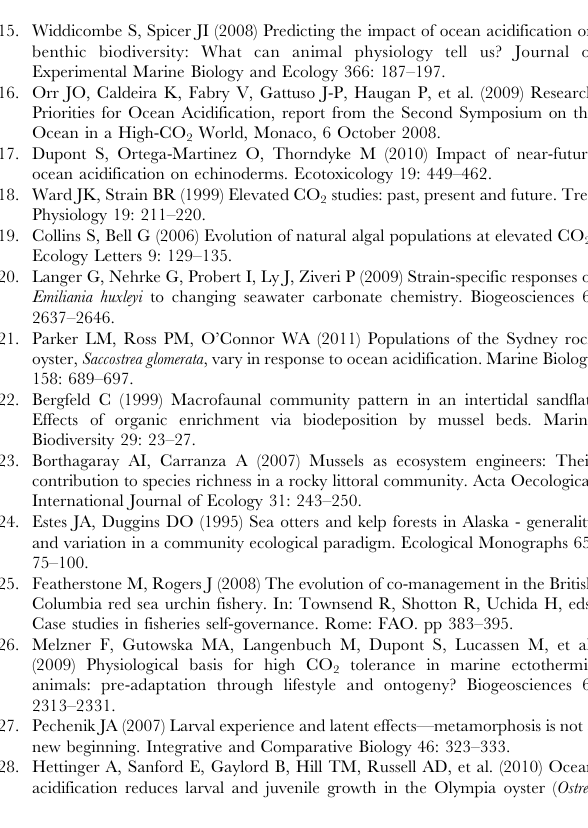
Figure S1 Variation in size-at-day under low and high CO 2 conditions in S. franciscanus , using the first principle component (PC1) of three skeletal rod lengths. ( A ) S. franciscanus larva at 7 days of development. Lines indicate length measurements for body length ( l ), post-oral arm ( a ), and transvers body rod ( t ) used in principle components analysis. Scale bar is 150 m m. ( B,C ) Variation in S. franciscanus PC1 after 5 days in ambient CO 2 (light grey bars) and elevated CO 2 (dark gray bars). Vertical bars indicate 6 1 standard deviation from the mean. The same data are shown partitioned among ( B ) sires and ( C ) dams. Horizontal lines represent means for ambient (dashed), and high (solid) CO 2 treatments. Heritability calculated from sire-based additive genetic variance, and maternal effects indicating variance attributed to dams over-and-above sire-based heritability, are given for each treatment (h 2 = heritability, m 2 =maternal effects). PC1 loadings were: a =0.51, b = 0.58, c = 0.63, all loading with the same sign, and representing 0.53 of the variance. Figure S2 Hypothesized fitness functions for develop- ment time used in evolutionary simulations of (A) Mytilus trossulus and (B) Strongylocentrotus francisca- nus . Red lines represent the loss of fitness with greater development time due to a constant daily mortality rate in the plankton of 15% day 2 1 , blue lines represent the loss of fitness expected with extremely rapid (short) development times, and black lines represent the resulting fitness function, the product of the red and blue fitness functions. The shape of the blue fitness function was arbitrarily chosen such that the equilibrium of the